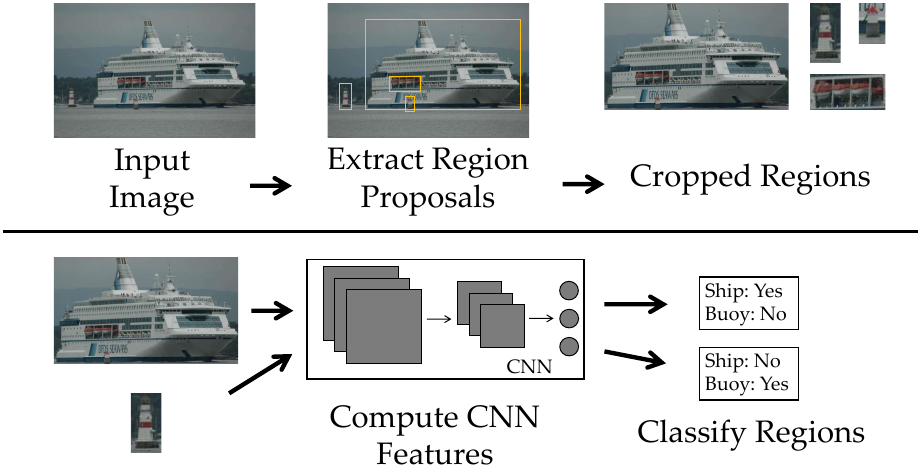
Figure 3. Regions with CNN